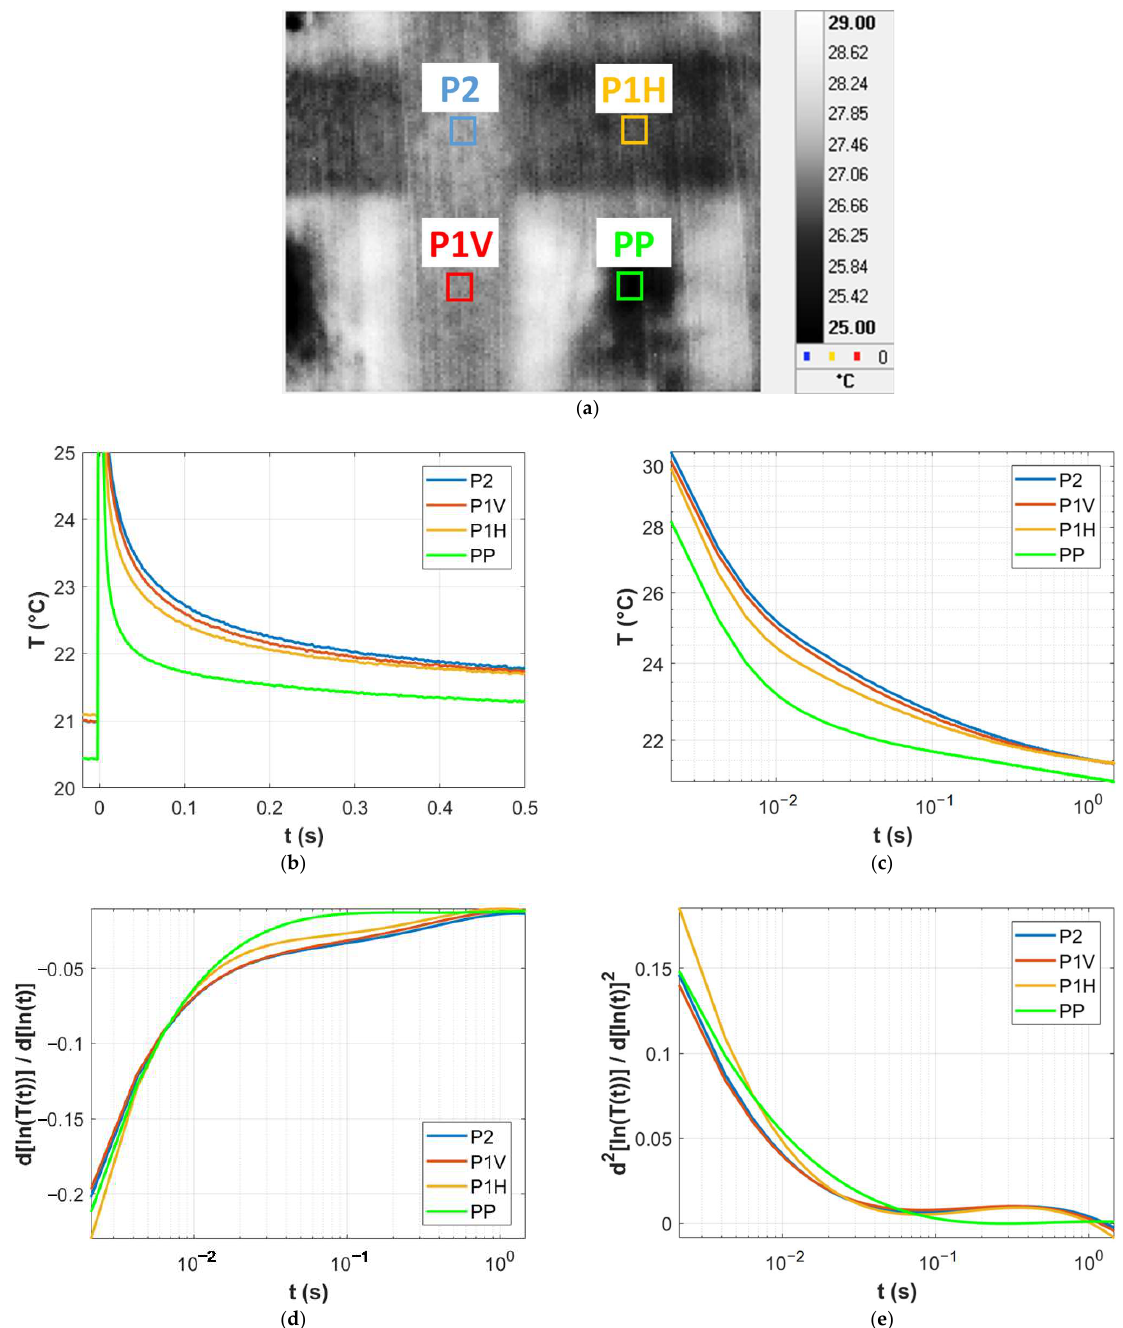
Figure 4. Raw thermal results: ( a ) Thermal map of the ROI at t = 2/472 s, with an indication of the processed regions; ( b ) thermal trend as a function of time, linear scale; ( c ) thermal trend as a function of time, logarithmic scale; ( d ) first derivative of the logarithmic Thermal Signal Reconstruction, semi-logarithmic scale; ( e ) second derivative of the logarithmic Thermal Signal Reconstruction, semi-logarithmic scale.